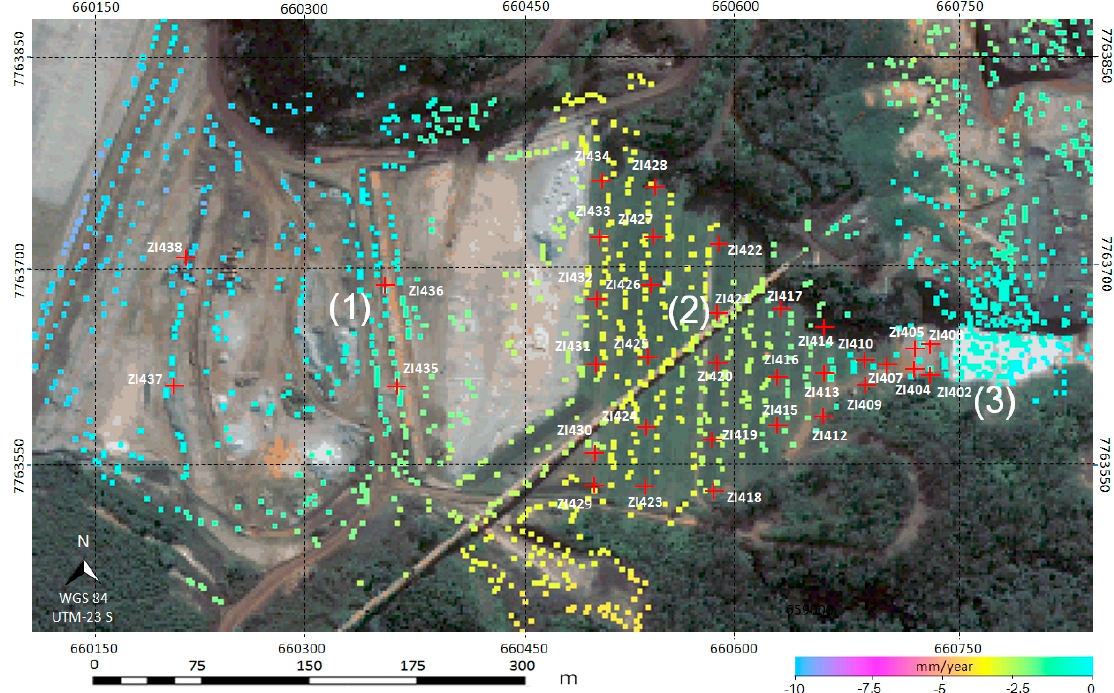
Figure 10. PSI ground displacement map in LoS showing the positions of the prisms and the upper sector ( 1 ), steepest sector ( 2 ), and buttress sector ( 3 ) of the main Germano dam.